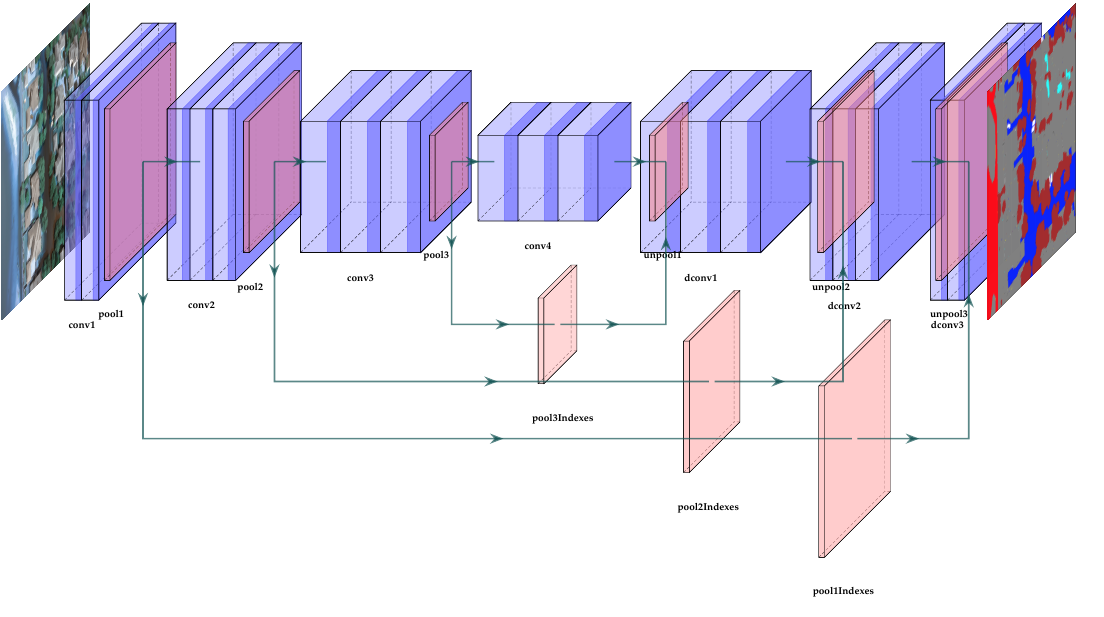
Figure 2. Simple deep convolutional autoencoder where you can see the two main parts of a network dedicated to image segmentation. Table 1: Hardware details of the hardware used in our experiments. dedicated to image